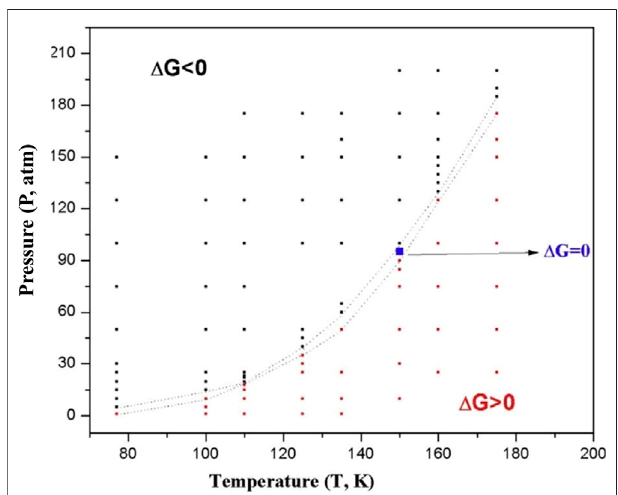
FIGURE7| T-PphasediagramfortheadsorptionofsixH 2 moleculeson B 3 ( μ -Li) 3 H 3+ .Theblackmarkersindicateregionsoffavourableadsorptionand red markers indicate that of favourable desorption (Reproduced from Pan et al., 2011 with permission from John Wiley and Sons. Copyright © 2011 Wiley Periodicals,